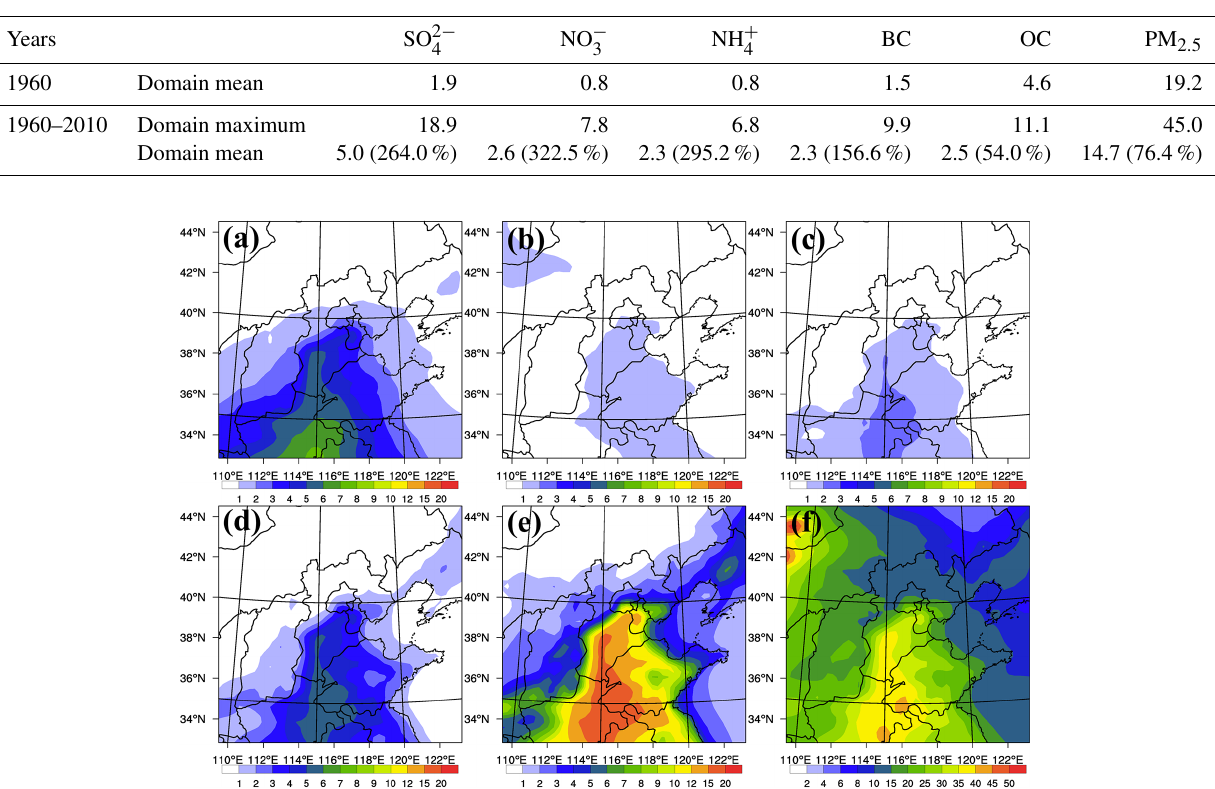
Figure 2. Predicted monthly mean sulfate (a) , nitrate (b) , ammonium (c) , BC (d) , OC (e) , and PM 2 . 5 (f) concentrations based on emissions for year